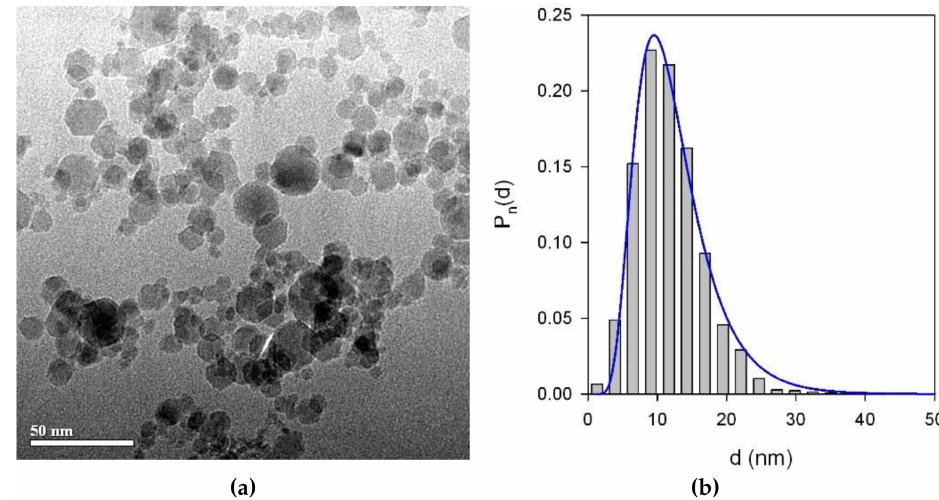
Figure 3. TEM micrograph (JEOL JEM2100) of maghemite γ -Fe 2 O 3 LTE MNPs ( a ) used for the synthesis of ferrogel. Particle size distribution ( b ) was obtained by a graphical analysis of 2160 TEM images of MNPs. The line in the PSD corresponds to lognormal fitting of the experimental data.